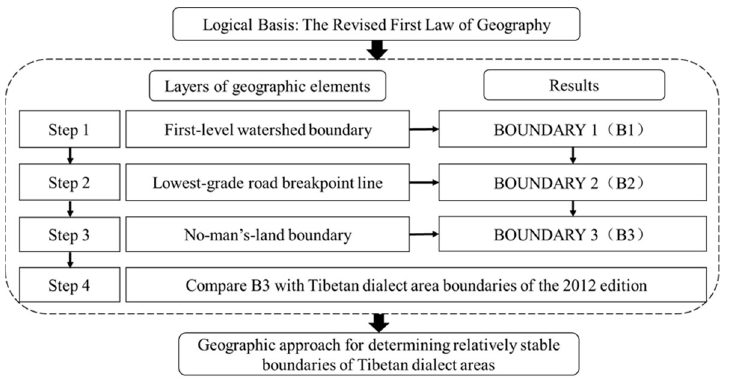
Figure 2. Method framework. (The logical basis of this study is the revised First Law of Geography. Three superimposed geographic elements are selected to determine the (sub)dialect area boundary: the boundary of the first-level watershed, lowest-grade road breakpoint line, and no-man’s-land boundary). The method employed in this paper was the layer overlay Geographic Information System (GIS) analysis method, which was divided into four steps. The first step was to select natural elements with high stability as basic dialect area boundaries. The second step was to determine the (sub)dialect area boundaries by connecting the breakpoints